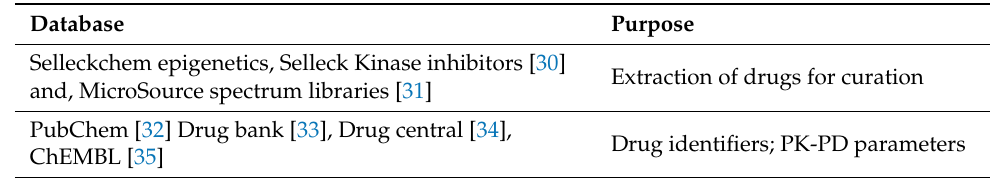
Figure 1. ( A ) Assembly of the CoviRx database, showing compound numbers from the original commercial sources ( top ) flowing into the Open Drug collection ( middle ) and though to the final database ( bottom ) ( B ) Workflow of the data curation process. Table 1. Drug databases used for data